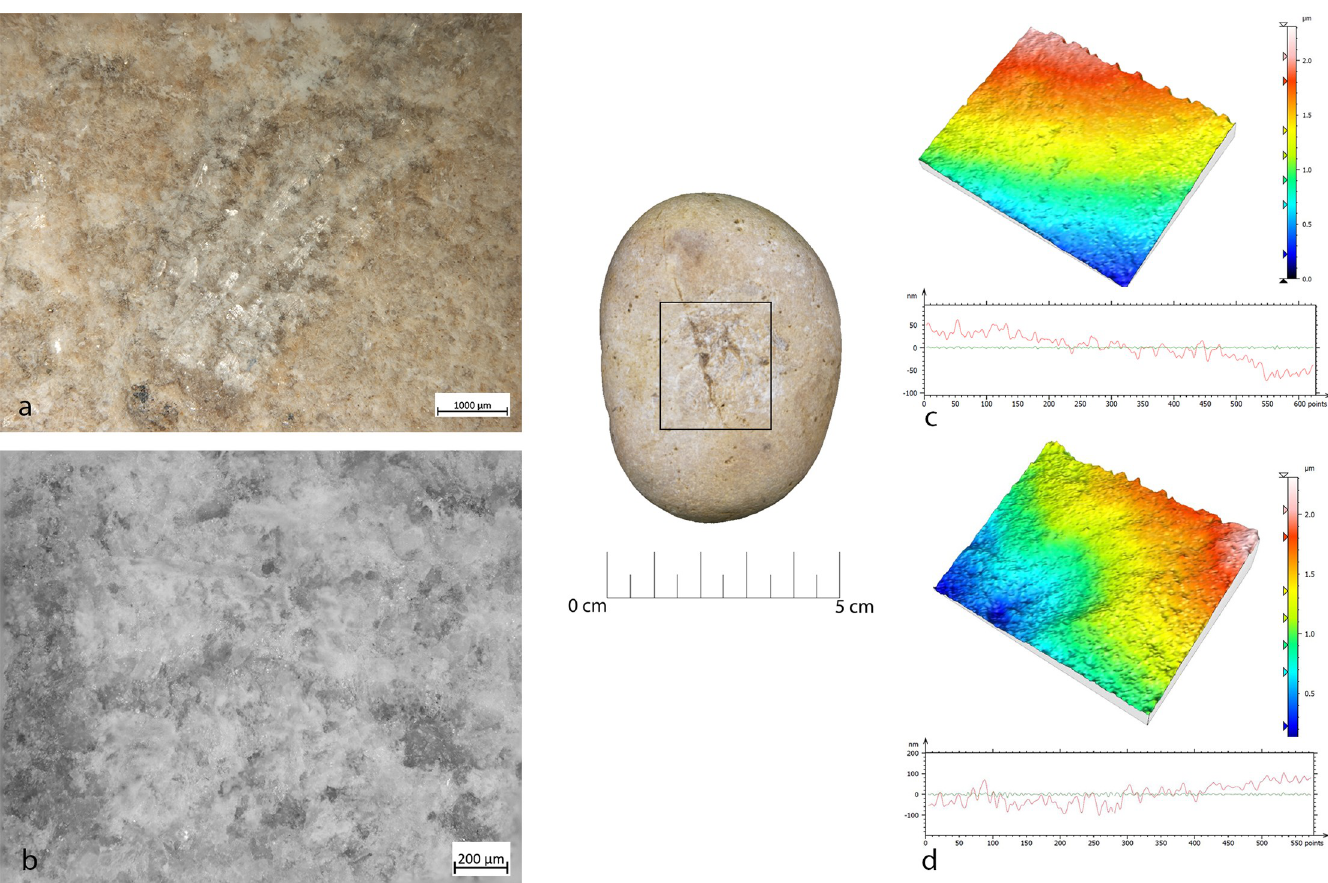
Fig 9. FA-8 use wear on experimental replica used in passive percussion. (a) Macro-traces (40x) consisted of large pits with sub-quadrangular/triangular morphology, grains appeared fractured, located in the central area of the flat surface of the pebble; (b) the micro-traces (200x) are absent, the bottom of the pits appear rough; (c) 3D microtopography of the unused surface and profile; (d) 3D microtopography of the used surface and